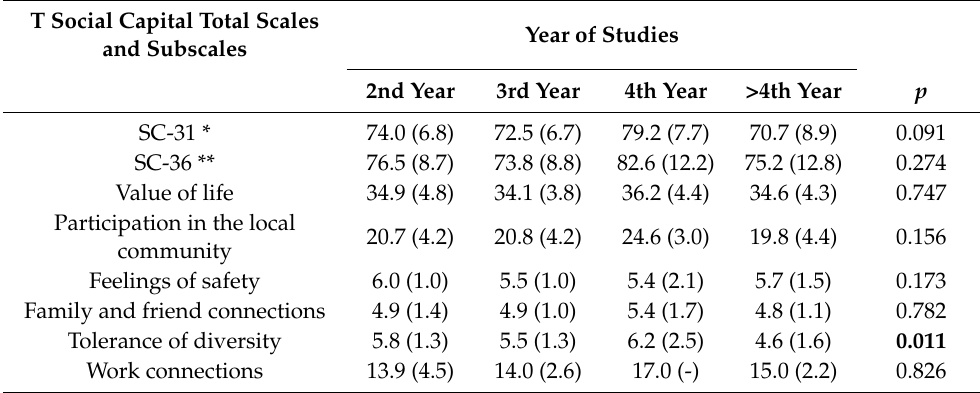
Table 5. Social capital scores by year of studies (mean, sd). T Social Capital Total